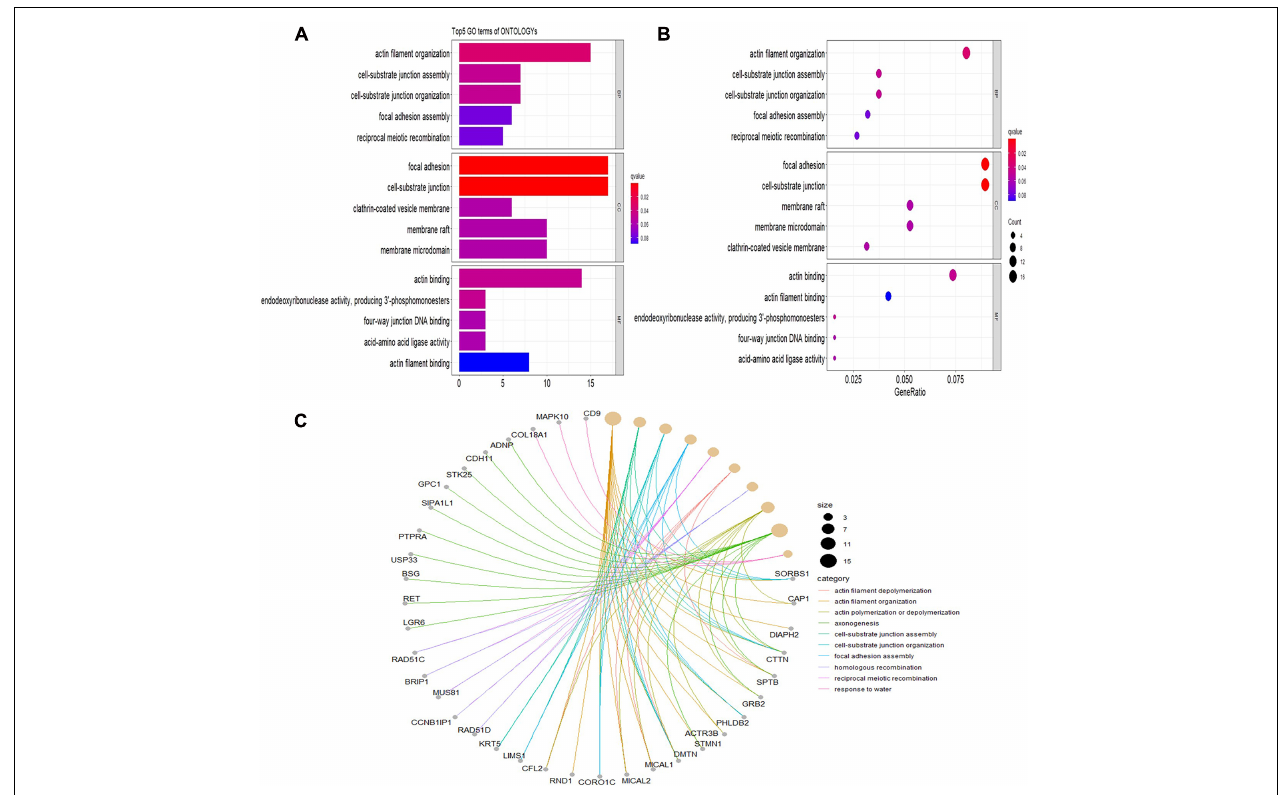
FIGURE 3 | Significantly enriched Gene Ontology (GO) terms of differentially expressed genes based on their functions. (A) Bar chart of the top 5 BP, CC, and MF terms in the enrichment analysis. (B) Bubble map of the top 5 BP, CC, and MF terms in the enrichment analysis. (C) Chord plot of the top 5 BP, CC, and MF terms in the enrichment analysis. BP, biological process; CC, cellular component; MF, molecular